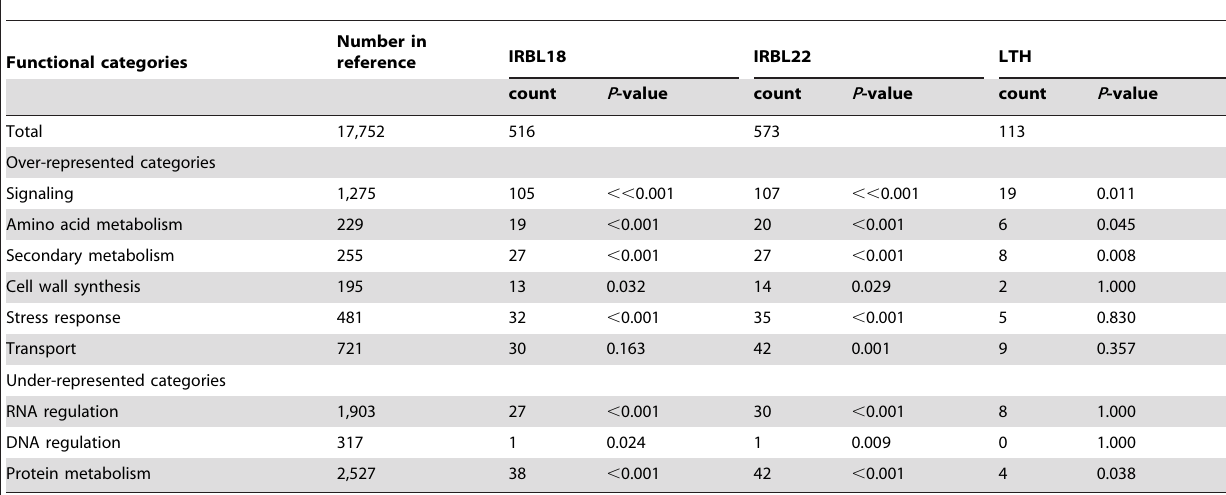
Table 2. The enrichment analysis of functional categories in the up-regulated